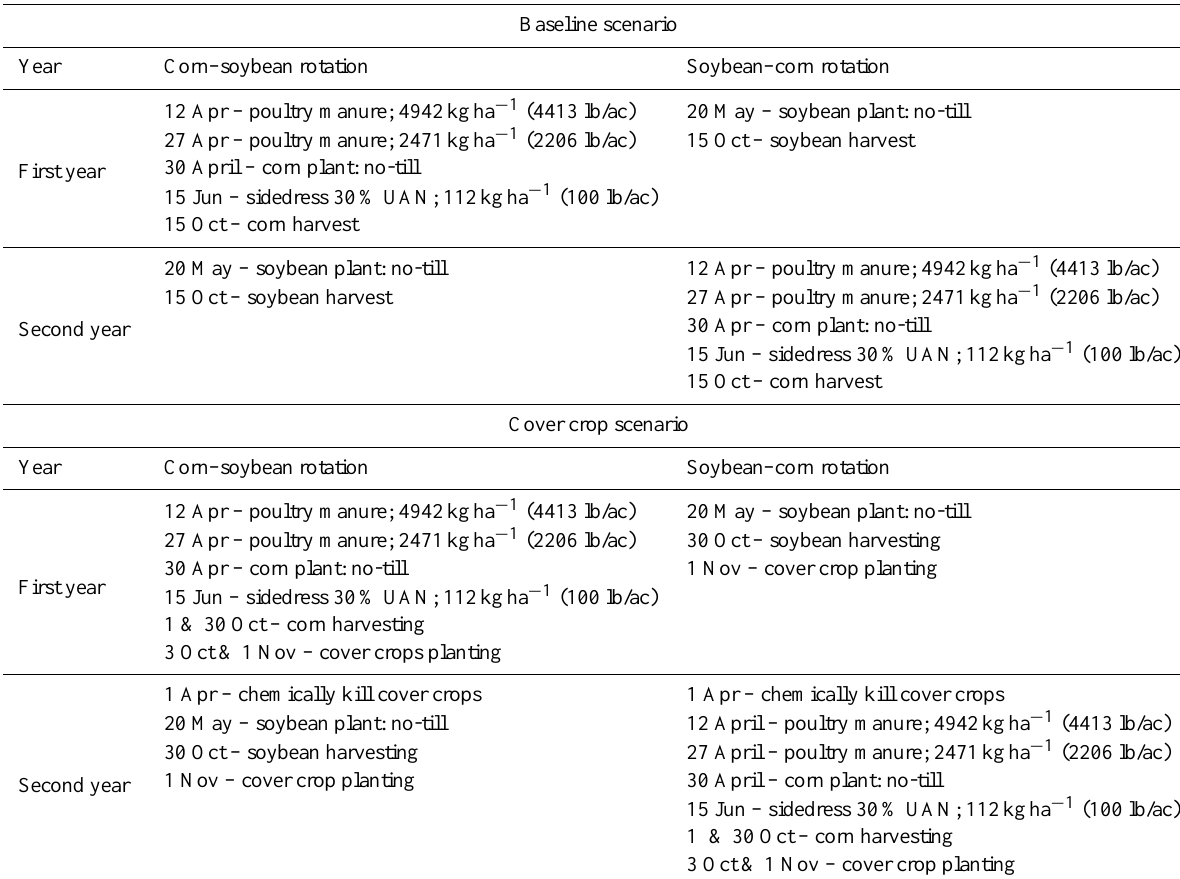
Table 4. Agricultural practices and management scheduling for the baseline and cover crop